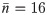
Burst killing and non-identifiability of dynamically interacting, multiple hitting CTLs.A) Schematic of the dynamic model (example with η = 3). Target cells are represented by circles containing fractions (numerator: hits received; denominator: η). The observable state [C U] consists of the total number of contacting, C, and non-contacting targets, U. The complete state of the system is represented by a matrix, with η rows indicating the number of hits received (subscript) and with columns indicating whether the target is contacting (ci) or non-contacting (ui). B) Measured killing events (red dots, filled white) during Monte Carlo simulations with Nw
= 10 CTLs and the number of targets drawn from a Poisson distribution with mean n¯=16 (top panels; λ,η = 10,koff = 0,kon→∞), or a subset of targets at risk (bottom panels; λ,η = 10,kon = 1hr−1,koff = 0.3hr−1). Each horizontal strip is one single simulation, the right panel strips are colored according to the total number of alive targets and the left panel strips are colored according to the number of targets that are in contact with a CTL. C) Each line (coloured according to η) is the mean cumulative killing over time (CTL-1) from Nw = 104 CTLs, simulated using parameters estimated by fitting the case with n¯=16 targets (central column). Straight lines show target values for fitting. All parameters except n¯ are constant across columns. D-F) Measured statistics within simulations with n¯ = 16 shown in the central column of C. Shown are the distribution of killed targets after 12 hours, with the mean and variance as indicated for each η (D), and the mean killing rate over time for CTLs grouped by η and shown either separately (E, rows), or together (F, colors), calculated as (kills⋅(6 min⋅Nw)−1).